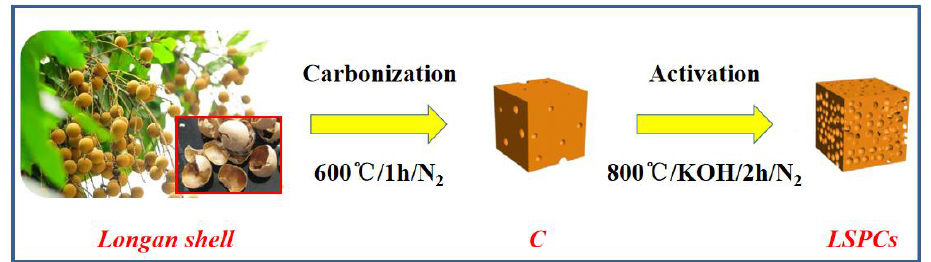
Figure 1. Schematic illustration of turning longan shell into longan shell 3-dimensional porous carbons (LSPCs). KOH, potassium hydroxide.